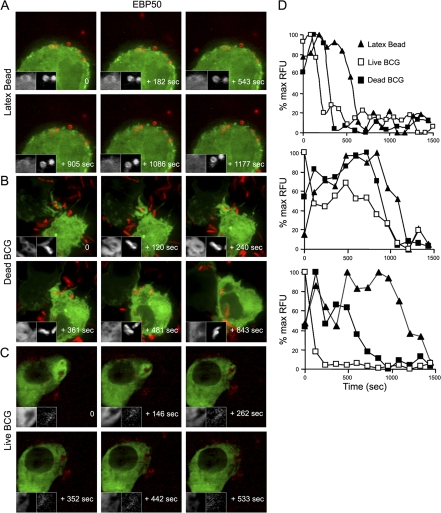
Faster Desorption of EBP50-GFP from Phagosomes Containing Live MycobacteriaMacrophages were transfected with EBP50-GFP and stimulated with IFN-γ and LPS for 16 h. Cells were infected with Texas Red–labeled latex beads, live or dead mycobacteria, and analyzed by live confocal microscopy.(A–C) Frames from time-lapse microscopy illustrate that phagosomes with latex beads (A) and dead mycobacteria (B) acquire and retain EBP50 longer than live mycobacteria (C) which rapidly lose EBP50.(D) Quantification of EBP50-GFP recruitment to phagosomes. Percent phagosome fluorescence relative to the maximum fluorescence intensity is shown as a function of time. Kinetics of three independent experiments for latex bead, dead mycobacteria, and live mycobacteria phagosomes are represented.